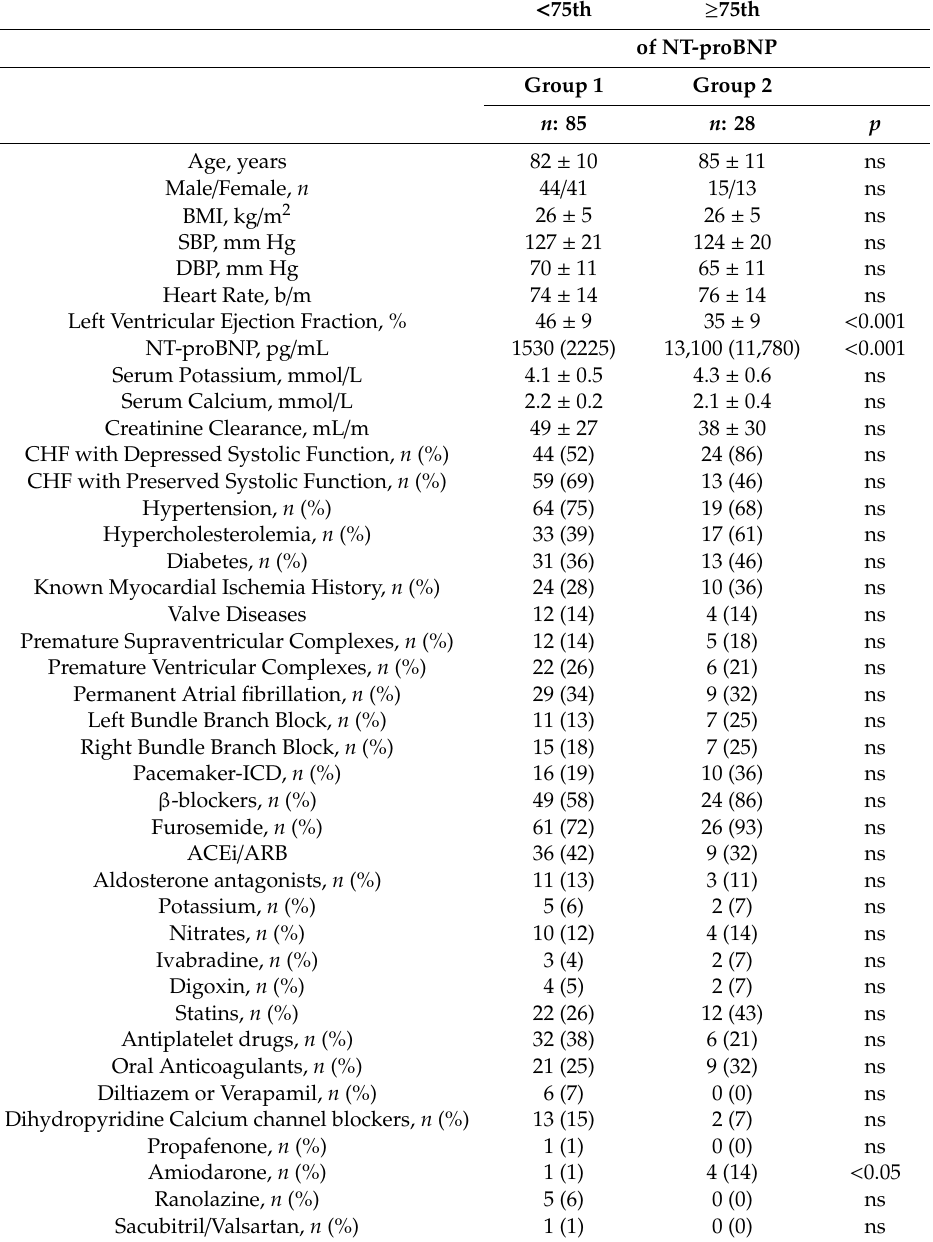
Table 1. General characteristics of the study